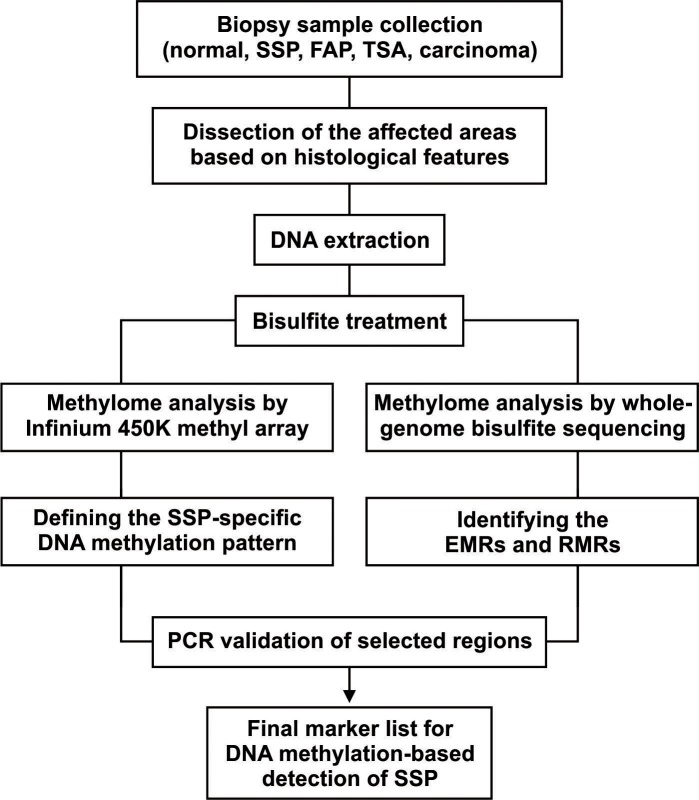
The workflow to determine the SSP-specific DNA methylation markers.The workflow shows the steps from sample collection to determination of the SSP-specific DNA methylation markers.